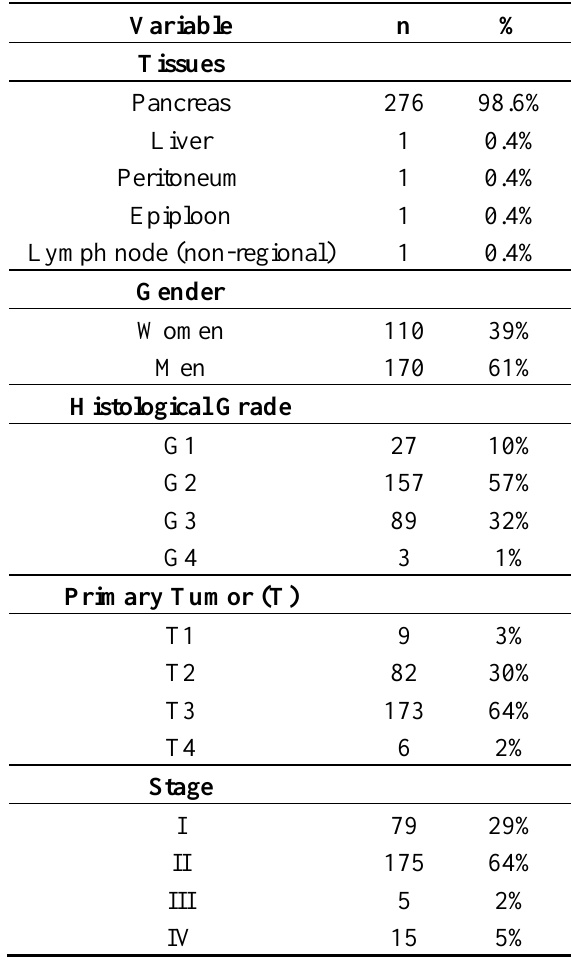
Table 2. Descriptive statistics of pancreatic adenocarcinoma in the tissue microarrays.